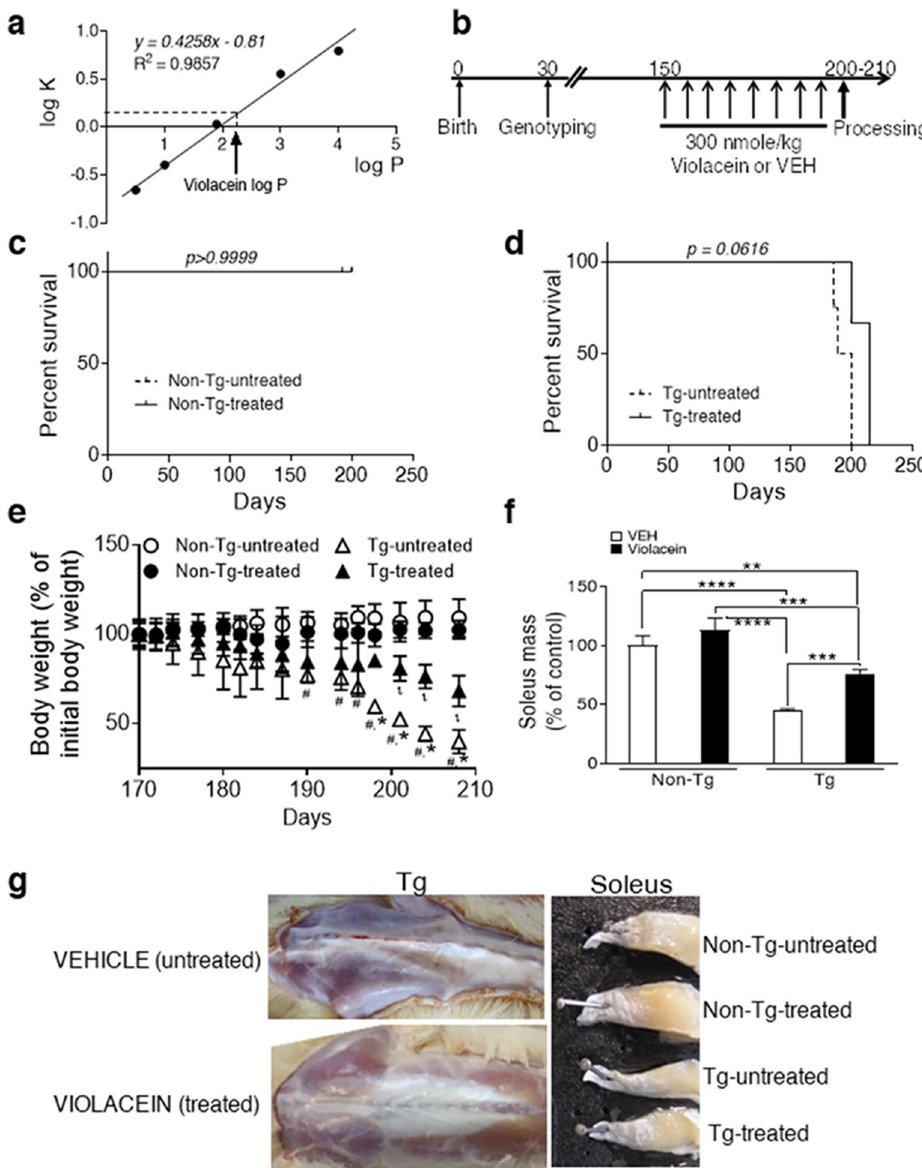
Figure 2. Violacein: log P determination and in vivo treatment. ( a ) Linear correlation between standard´s log K versus log P and interpolation of violacein log P evidencing its potential capacity to cross the blood brain barrier. ( b ) Scheme of animal treatment performed in 150 day-old Non-Tg and Tg rats that received intraperitoneal injections of 300 nmole/kg violacein (300 µl) (called as –treated animals) or equal volume of vehicle (0.5% DMSO, called as -untreated rats). ( c ) Survival Kaplan-Meir curves showing absence of violacein effects in the lifespan of Non-Tg rats (p > 0.9999, Long-rank Mantel-Cox test). ( d ) Survival Kaplan-Meir curves of Tg rats showing a marginally significant delayed lifespan upon violacein treatment (~ 10 days, p = 0.0616, Long- rank Mantel–Cox test). ( e ) Body weight curve between 170 and 210 day-old for all experimental conditions. Differences related to Non-Tg rats that determined disease onset 16 became statistically significant at 180 day- old (#, p = 0.0374) for Tg-untreated ( △ ), and at 190 day-old (ι, p = 0.030) for Tg-treated ( ▲ ) rats, respectively. Different body weight loss between Tg-treated ( ▲ ) and Tg-untreated ( △ ) animals was found at 194 day-old (*, p = 0.041). Violacein did not affect the body weight of Non-Tg treated ( ● ) versus Tg-untreated rats ( ○ ). ( f ) Decreased soleus muscle mass in Tg-untreated related to Non-Tg rats (~ 50%, p < 0.0001), and attenuation of muscle loss in Tg-treated when compared with Non-Tg rats (~ 20%, p = 0.0001). ( g ) Significant reduced atrophy in gluteus muscles from a Tg-treated rat when compared with an age-matched Tg-untreated brother. On the right there are halves of soleus muscles from each experimental condition. Note the preservation of muscle mass when comparing Tg-treated with Tg-untreated samples. Numbers of animals employed and replicates done appear in Table